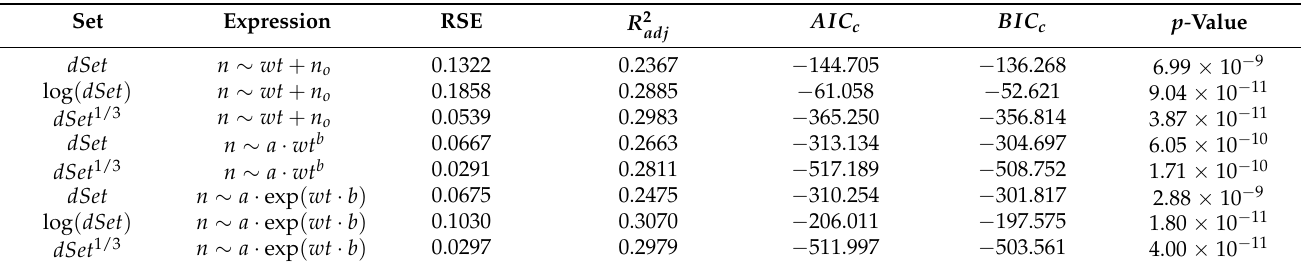
Table 8. Regression results for n vs. wt for the CMC